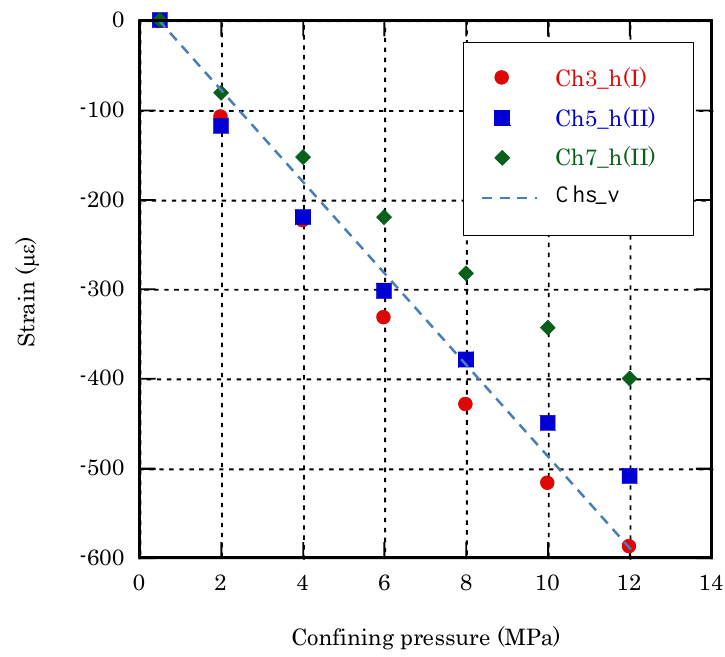
Figure 11. Tako core strain gauge readings at stage 1: ( a ) vertical strains; ( b ) hoop strains (with the dashed line representing the vertical strains). I—coarse-grain region; II—fine-grain region.